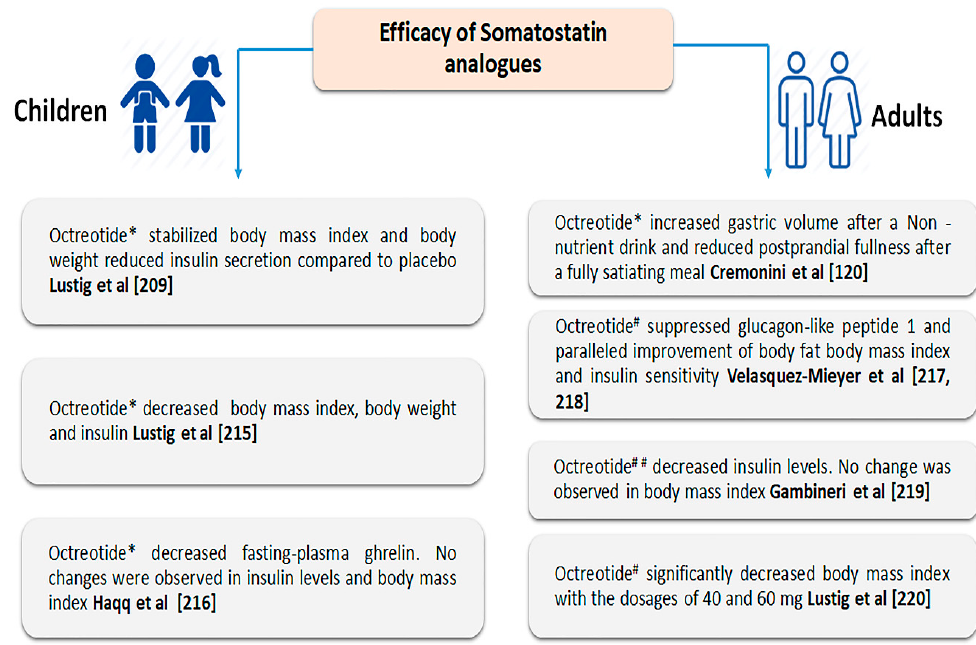
Figure 3. Comparative assessment of somatostatin analogues in the treatment of obesity in adults and children with different route of administration. * Subcutaneous; # long-acting release (intramuscular); ## long-acting drug with low-calorie diet.